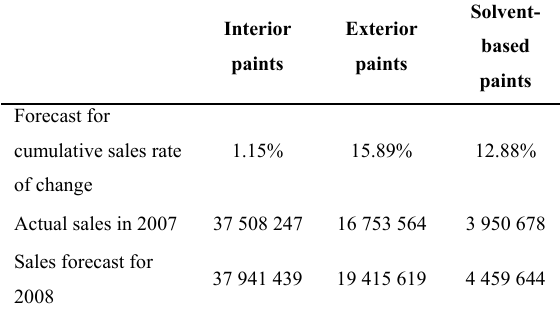
Table 1. Cumulative sales forecast for